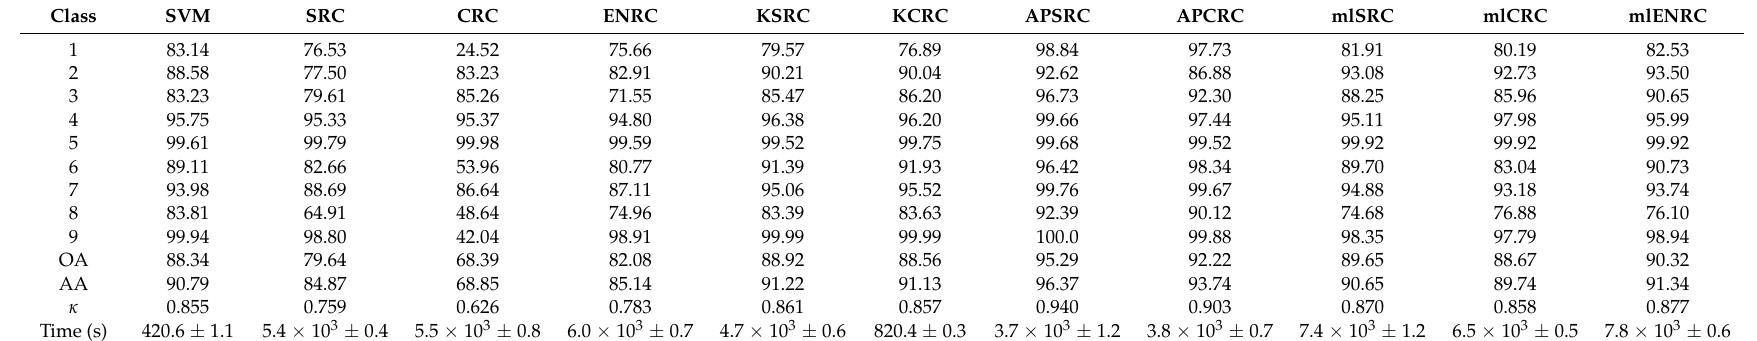
Table 6. Class-specific accuracy (%), overall (OA), average (AA), kappa ( κ ), as well as computational time in seconds with 120 training samples per class for the University of Pavia